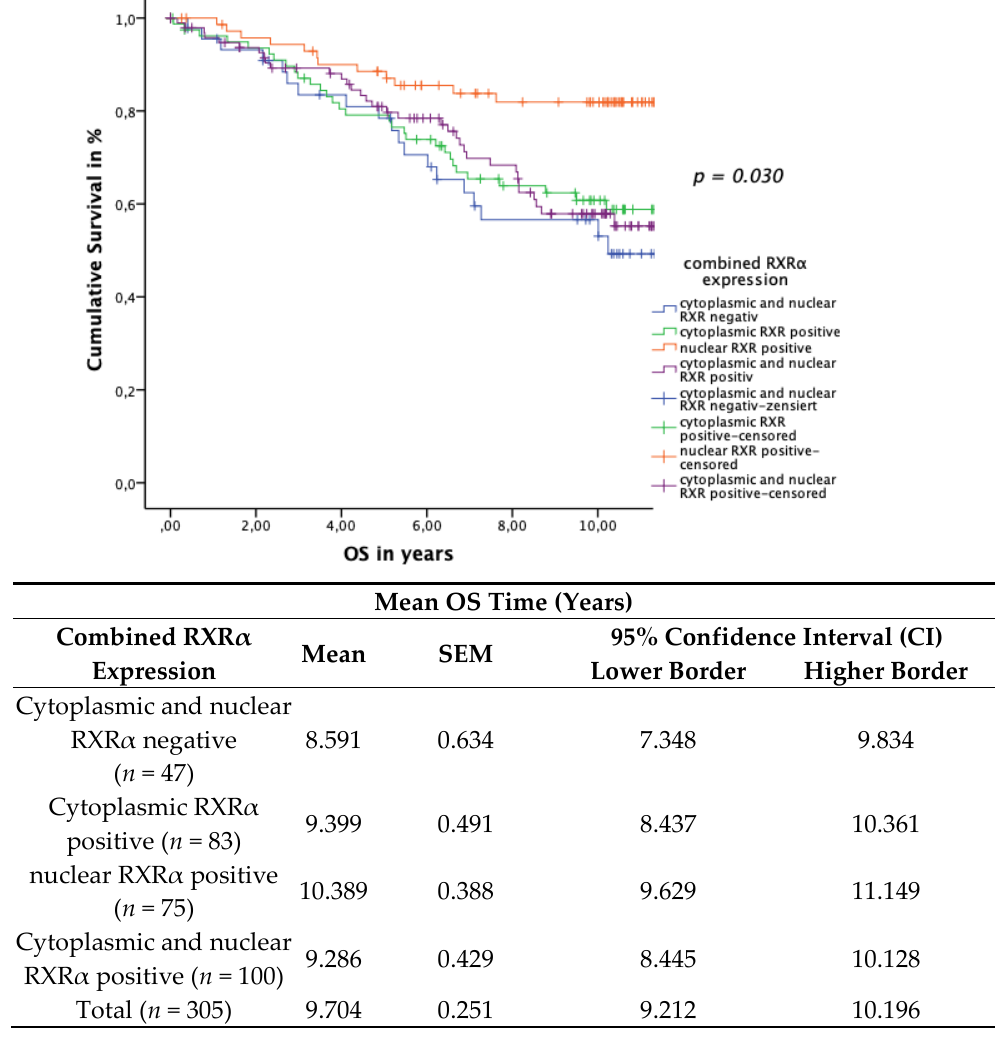
Figure 6. Kaplan –Meier survival analysis of the four combinatorial phenotypic RXRα groups and their expression in relation to OS. Statistical significance is shown as p -values determined using the log-rank-test ( p < 0.05). The risk table demonstrates the mean survival time, SEM and 95% confidence interval (CI) for univariate analyses.